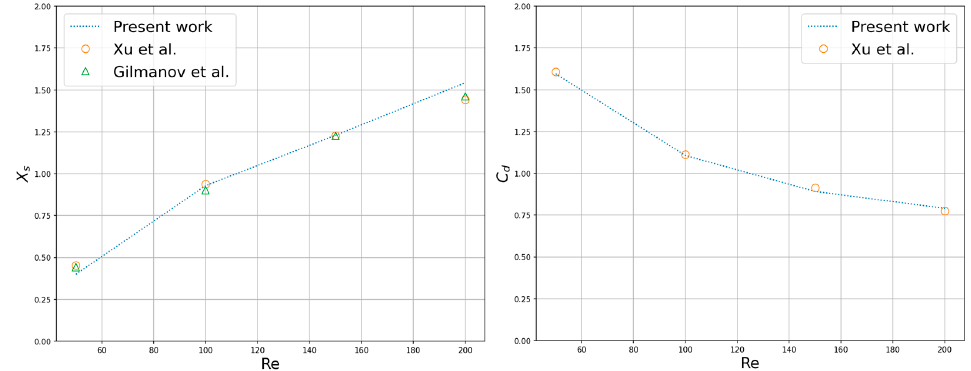
Figure 21. Flow geometry and drag coefficient affected at different Reynolds numbers [53,54].